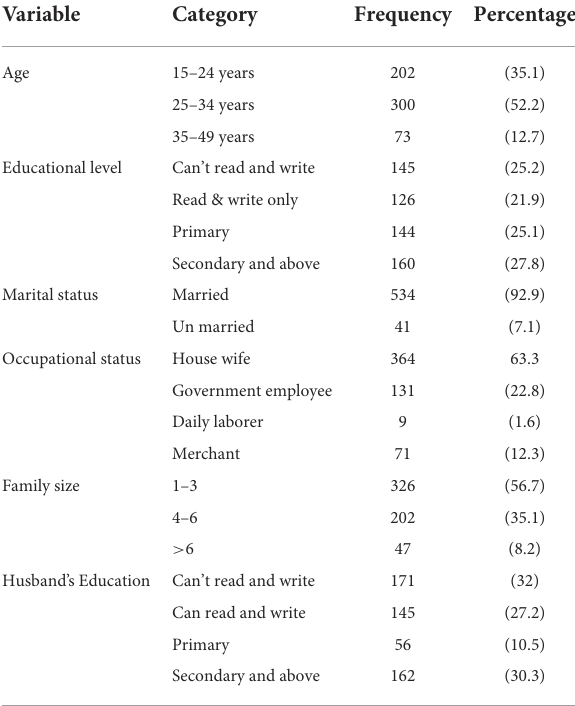
TABLE 1 Socio-demographic characteristics of pregnant women attending ANC clinic in governmental health institutions of Metema district, Northwest Ethiopia, May, 2021 ( N =